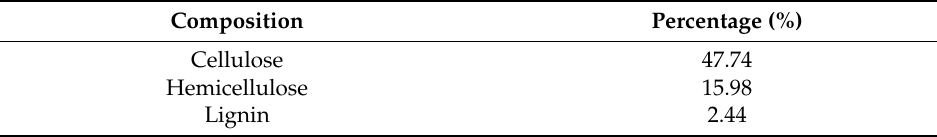
Table 2. Chemical composition of PALF [20].